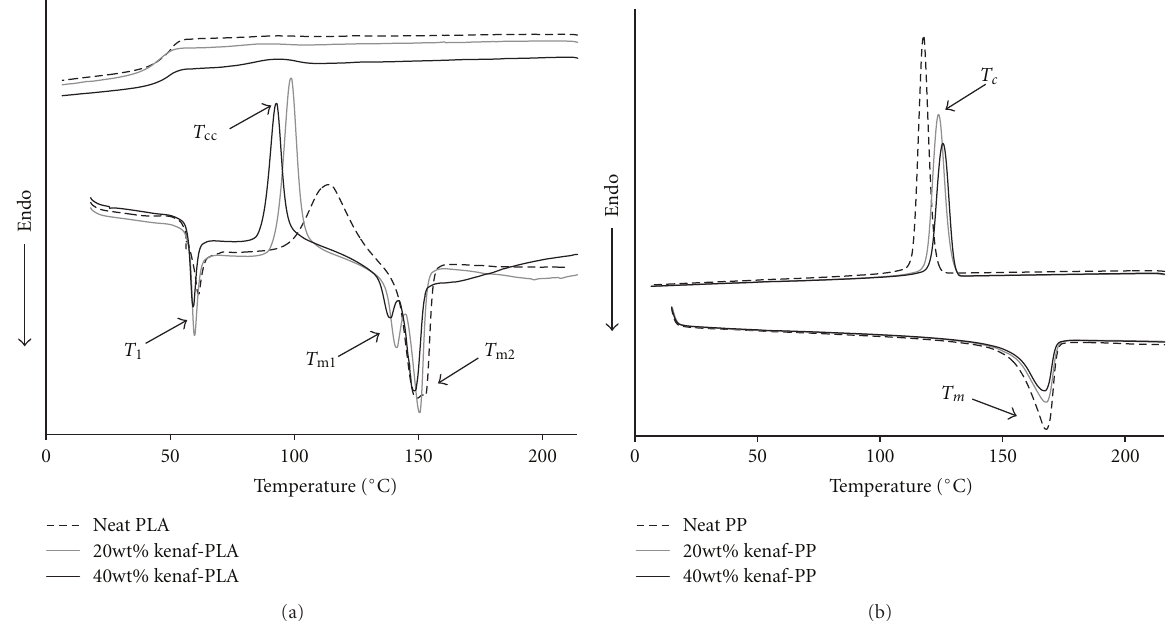
Figure 5: Di ff erential scanning calorimetry: heating and cooling traces of (a) PLA and PLA composites and (b) PP and PP composites.